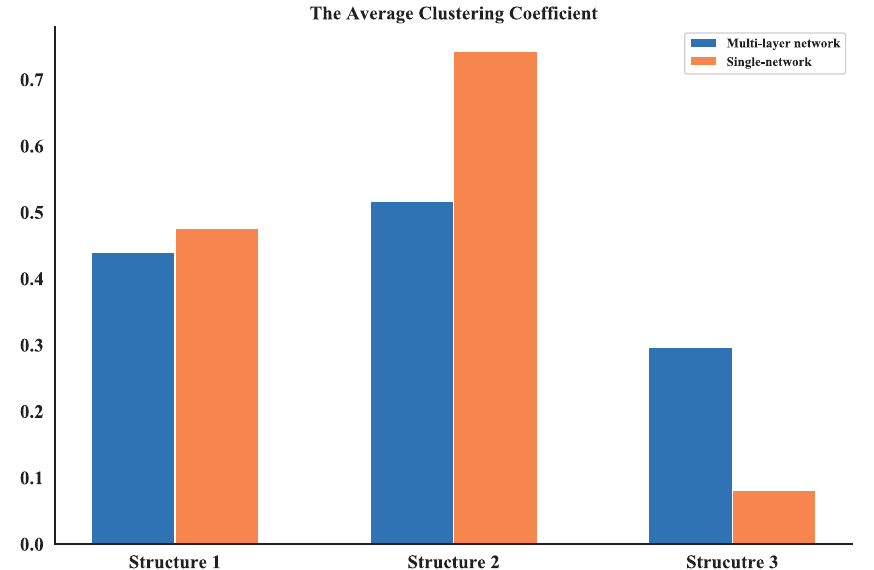
Figure 22. Comparison of average clustering coefficient between multi-layer network and single network.